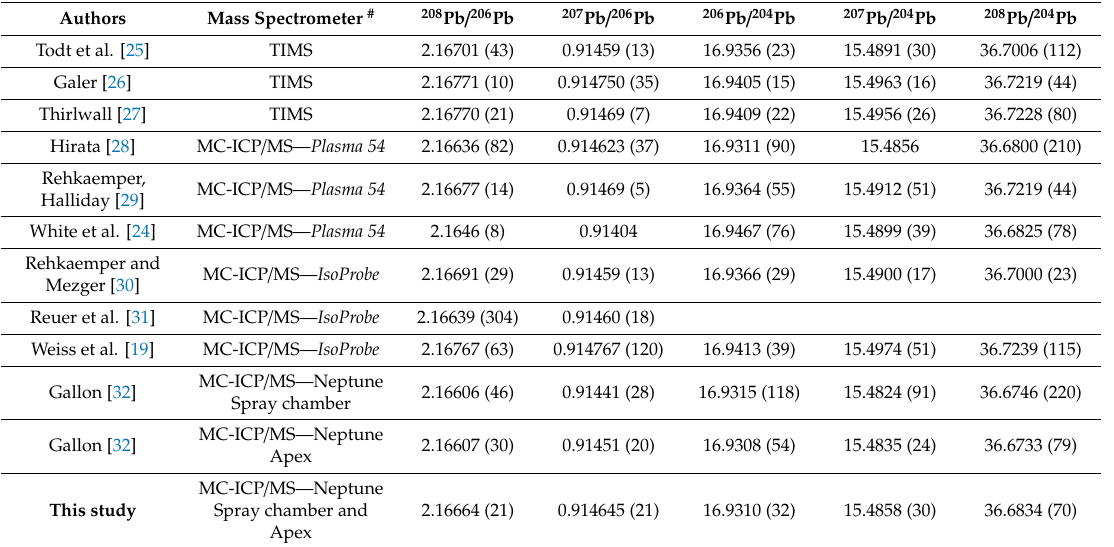
Table 3. Lead isotopic ratios values reported for NIST SRM 981 measured by TIMS and / or MC-ICP /